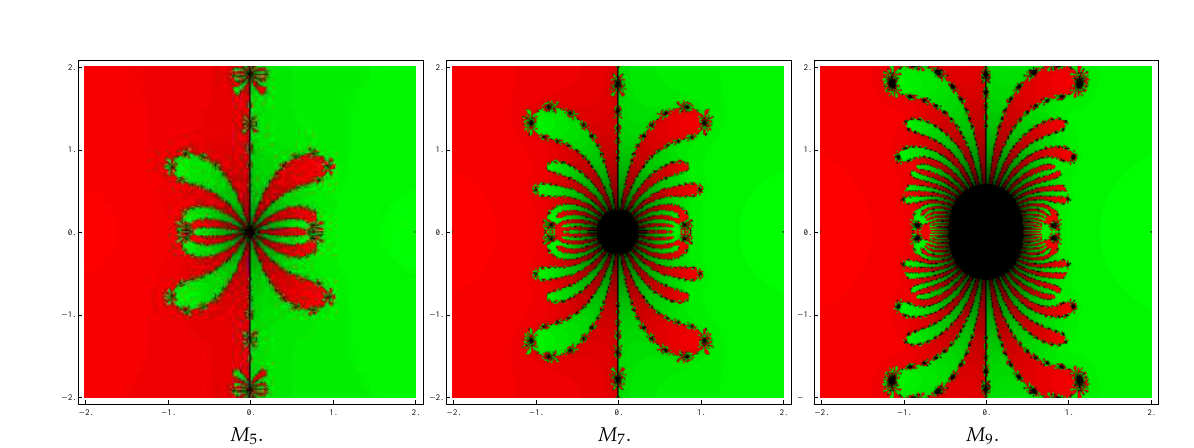
Figure 6. Basins of attraction of M 5 , M 7 , and M 9 for polynomial P 1 ( z ) .